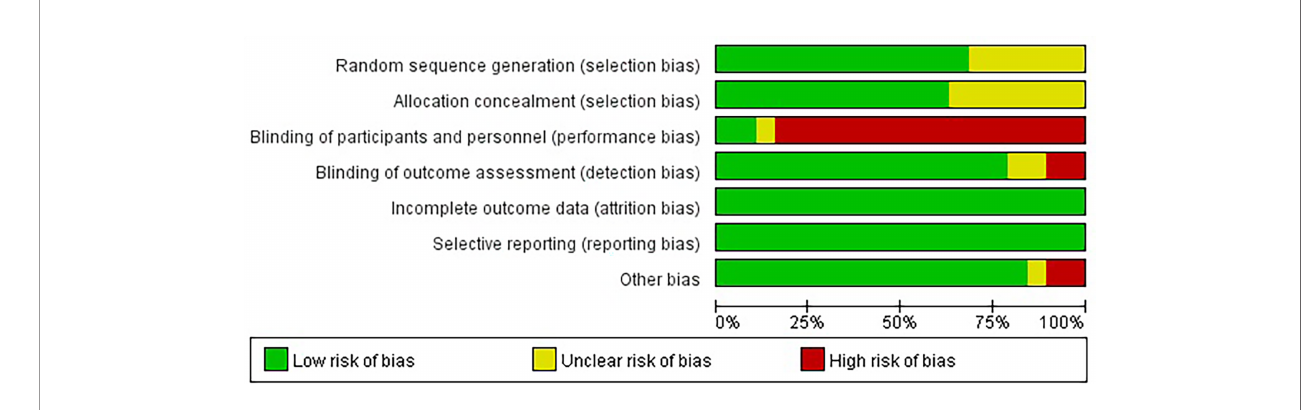
FIGURE 2 | Risk of bias graph.